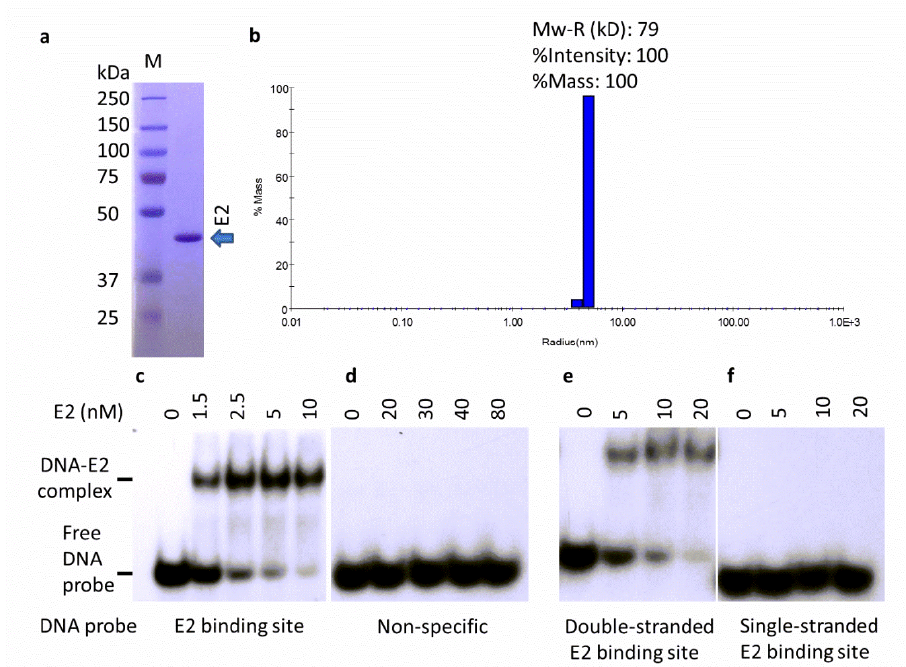
Figure 2. E2 protein purity, oligomeric structure, and DNA binding preference. ( a ) Coomassie Blue-stained SDS-PAGE shows purified E2 protein at a predicted size of 43 kDa. “M” represents Precision Plus Protein Standards (Bio-Rad). ( b ) Dynamic Light Scattering analysis of E2 protein sample, using three independent measurements. A representative DLS regularization graph of E2 protein showing a single mono-modal peak with a mass of 79 kDa is presented. ( c ) DNA binding by E2 protein was analyzed by EMSA using a 32 P-labeled BS4 or ( d ) non-specific DNA probe (Table 1). ( e ) E2 protein titration of either double-stranded or ( f ) single-stranded E2 binding site. The E2 protein concentrations were as indicated.